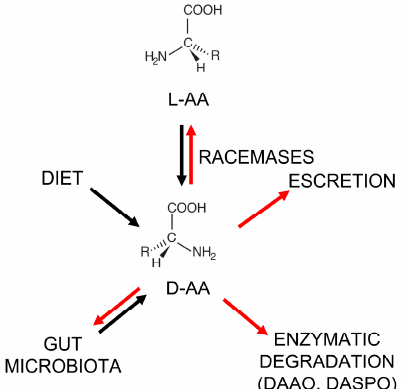
Figure 1. Metabolism of D-amino acids in the human body. Black arrows: synthetic pathways; red arrows: degradation/elimination pathways. L-AA = L-amino acid; DASPO = D-aspartate oxidase.